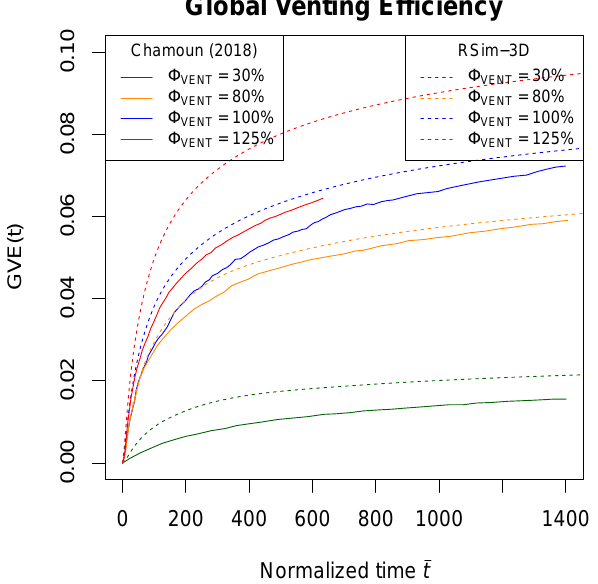
Figure 8. Global venting efficiency at different venting degrees φ VENT